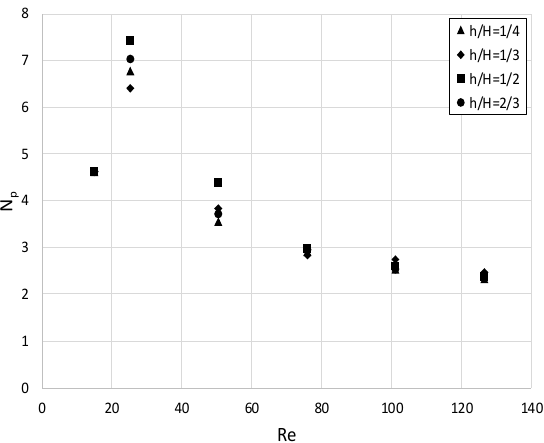
Fig. 3. Power number N p for Rushton turbine and for different impeller distances from tank bottom.